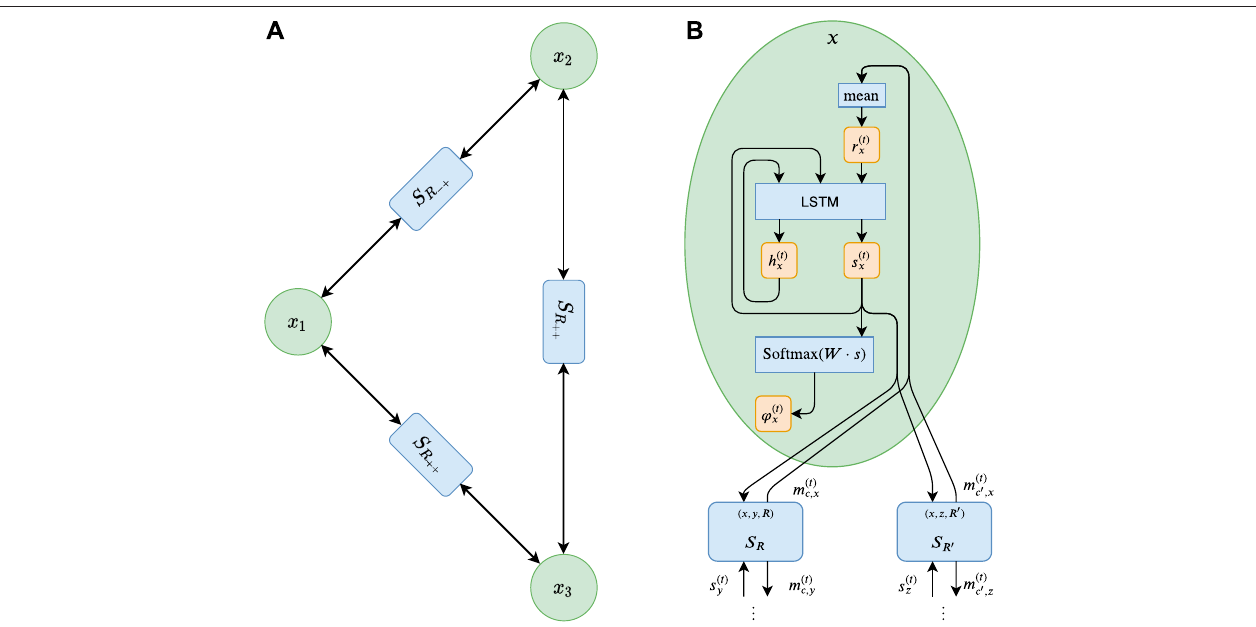
FIGURE2|(A) ThegraphcorrespondingtotheM AX -2-SAT-instancef (cid:2) (¬X 1 ∨ x 2 ) ∧ ( x 1 ∨ x 3 ) ∧ ( x 2 ∨ x 3 ) .Thenodesforthevariablesareshowningreen.Thefunctions through which the variables iteratively exchange messages are shown in blue (B) An illustration of the update mechanism of RUN-CSP. The trainable weights of this function are shared across all nodes, which allows RUN-CSP to process instances with arbitrary